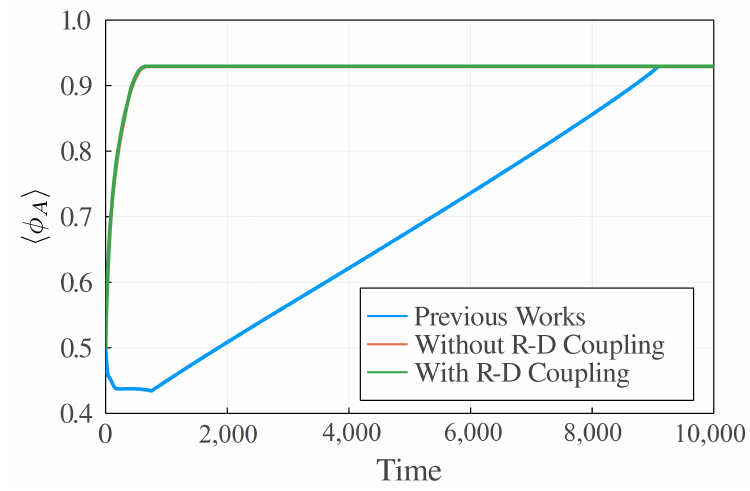
Figure 4. (cid:104) φ A (cid:105) ∼ t curves obtained by the equations of previous works [23,24], Equations (23) and (24) (without reaction-diffussion (RD) coupling terms) and Equations (25) and (26) (with RD coupling), respectively. The numerical simulations are performed on a 256 × 256 lattice. D = 1.0, k 0 = 1.0, χ = 3.0, b A = 0.5, b B = 0.8 and ∆ τ = 0.05.